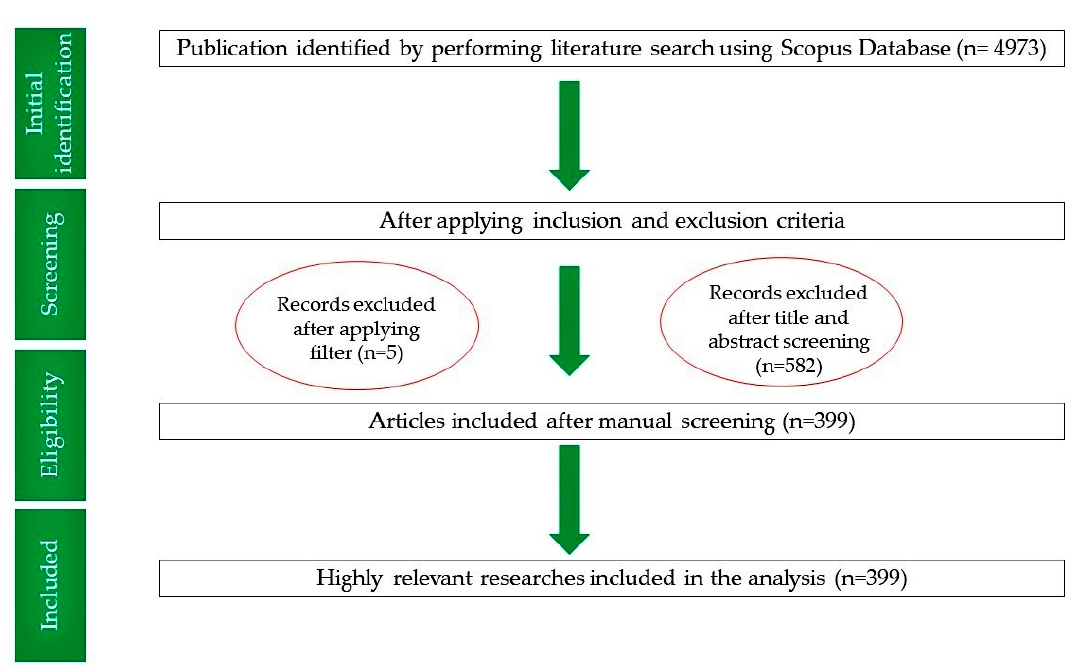
Figure 1. Four-phase flow diagram of data extraction and filtration process of publications related to salivary biomarkers.